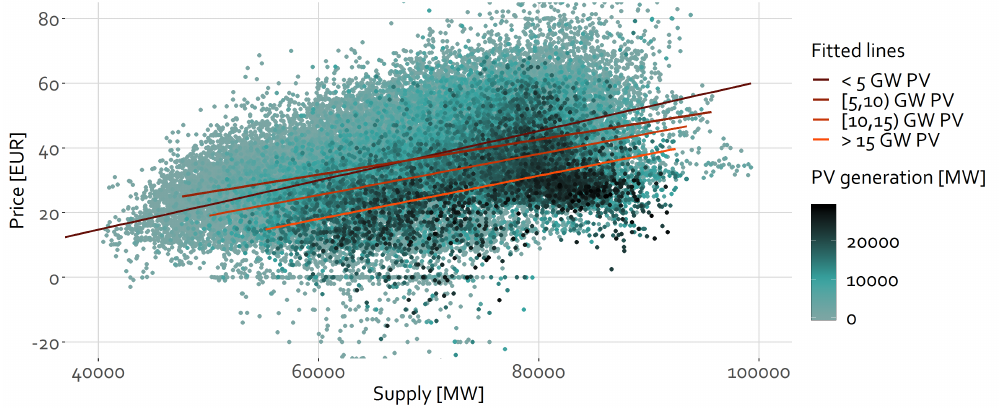
Figure 5. Scatter plot of total generation and price with different levels of PV energy, source: own